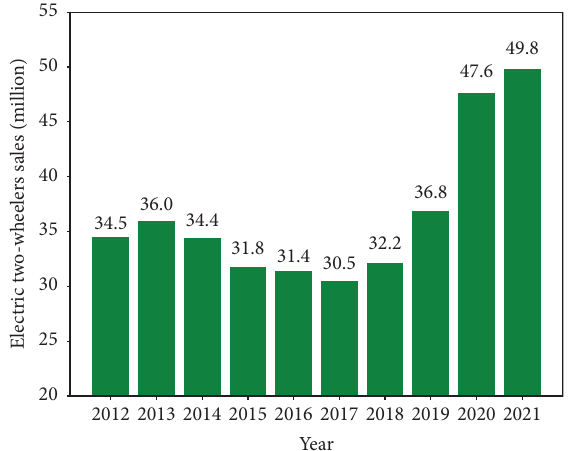
Figure 1: China’stwo-wheelersalesfrom2012to2021(source:EVTank).